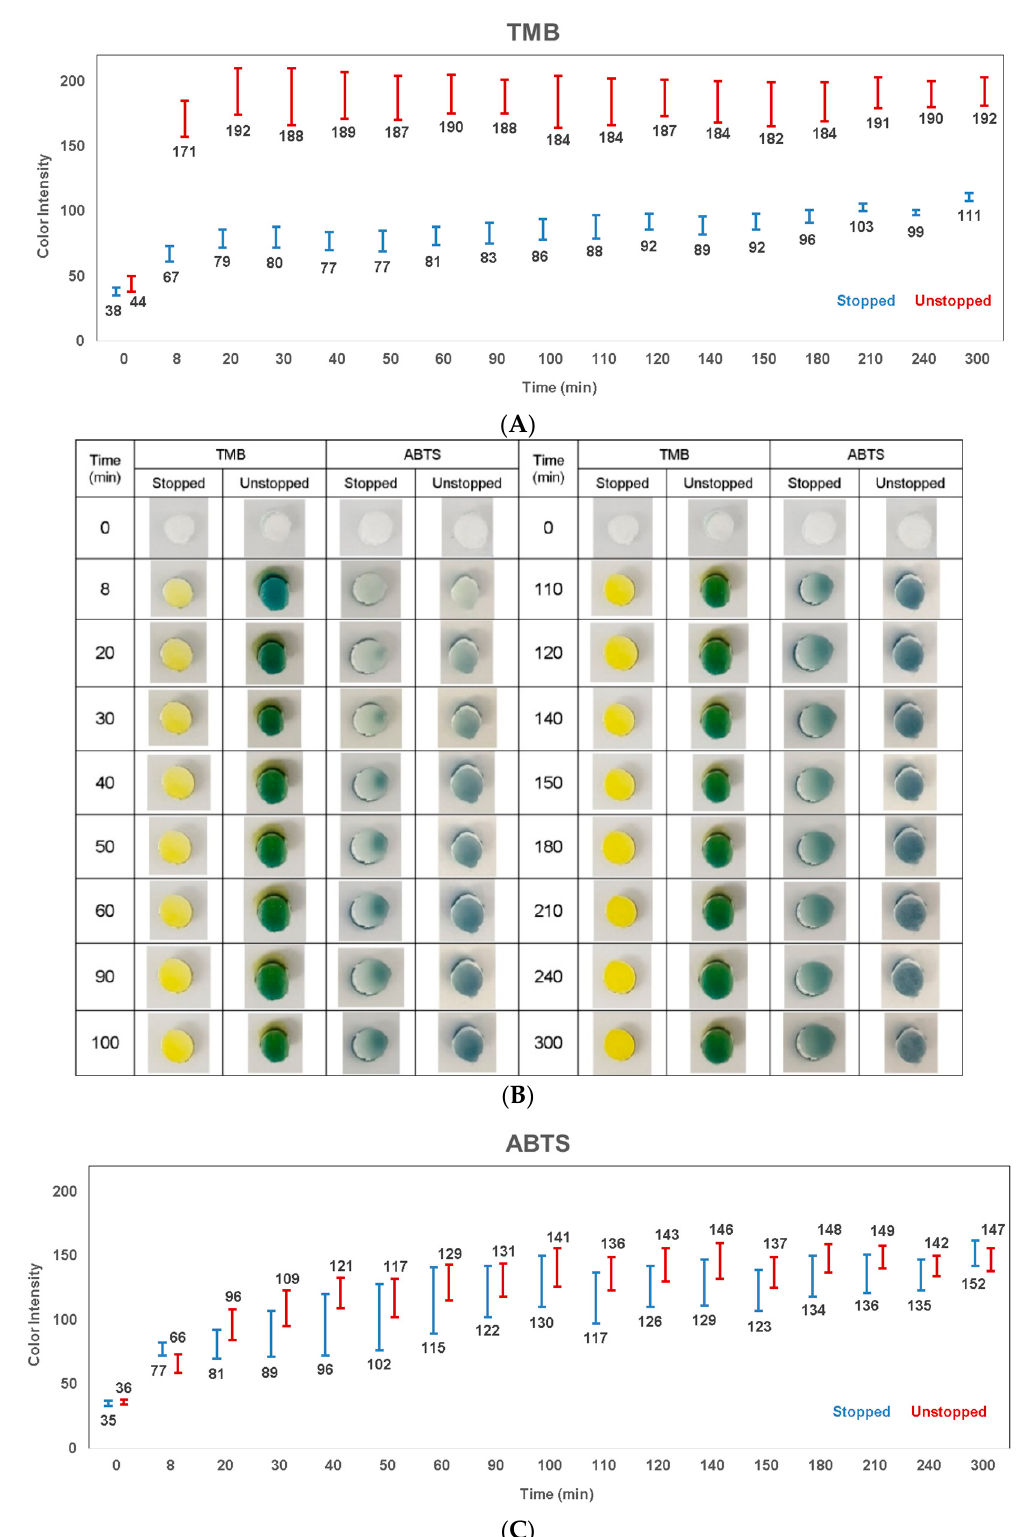
Figure 7. Stopped vs. unstopped colorimetric signal stability over time. Two substrates were compared: 3,3’,5,5’-tetramethylbenzidine (TMB) vs. 2’-azinobis (3-ethylbenzothiazoline-6-sulfonic acid) (ABTS) for unstopped vs. stopped colorimetric signal comparison on membrane. ( A ) TMB; ( B ) picture; ( C ) ABTS.